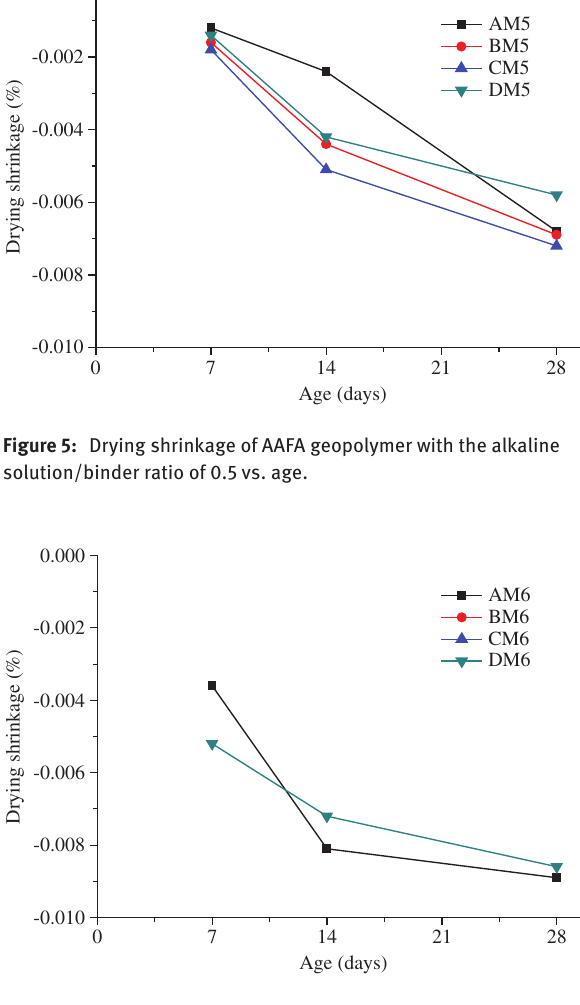
Figure 6: Drying shrinkage of AAFA geopolymer with the alkaline solution/binder ratio of 0.65 vs. age.